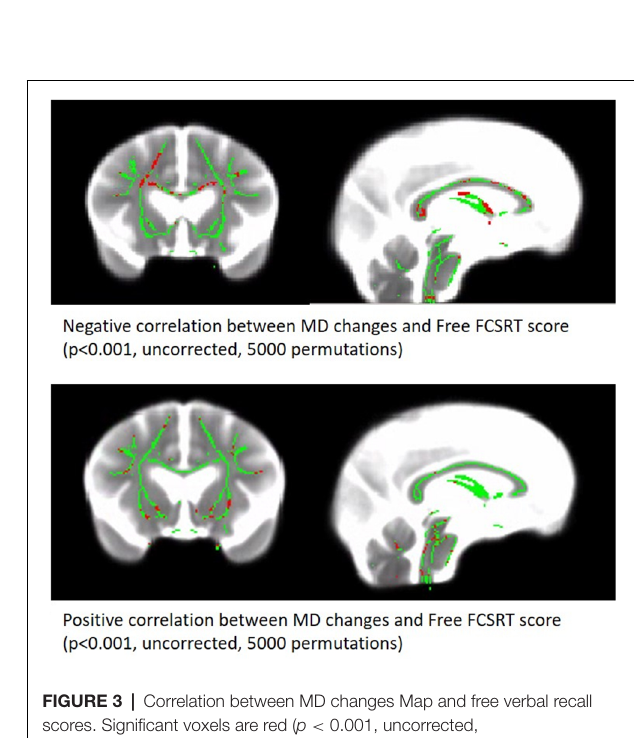
FIGURE 2 | Skeleton ROIs in yellow presenting a significant increase of the mean diffusivity (MD) between the two diffusion MRI scans for the whole group, overlaid on a subject MD map (one sample t -test, p < 0.05, TFCE corrected). (A) Axial view and (B) sagital view.